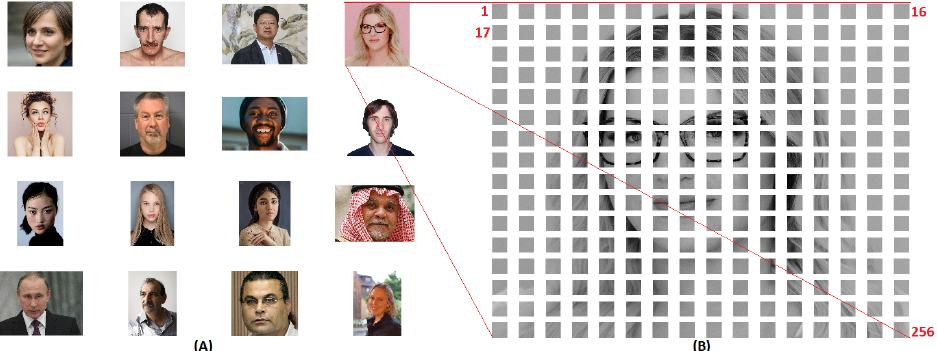
Figure 4. Blocks generation: ( A ) the 16 facial images for masks bank, and ( B ) the 256 generated blocks. Subsequently, a Mean Absolute Error (MAE) was calculated for these 4096 normalized generated blocks of size 16 × 16, in order to build the MAE matrix of size (4096 × 4096), as outlined in the Equation (7). The MAE matrix was implemented to allocate the similarity between the generated blocks which were acquired from these sixteen facial